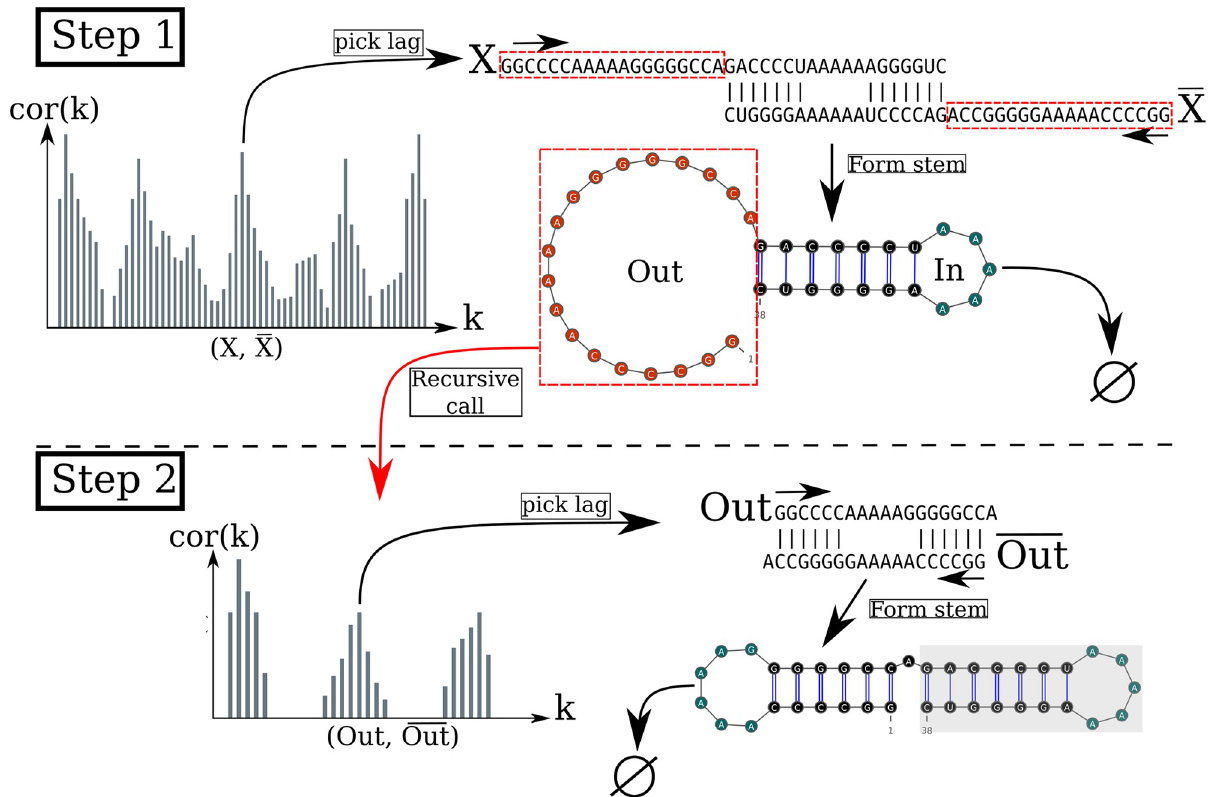
Fig 2. Algorithm execution for one example sequence which requires two steps. (Step 1) From the correlation cor ( k ), we select one peak which corresponds to a position lag k . Then, we search for the largest stem and form it. Two fragments, “In” (the interior part of the stem) and “Out” (the exterior part of the stem), are left, but only the “Out” may contain a new stem to add. (Step 2) The procedure is called recursively on the “Out” sequence fragment only. The correlation cor ( k ) between the “Out” fragment and its mirror is then computed and analyzing the k positional lags allows to form a new stem. Finally, no more stem can be formed on the fragment left (colored in blue), so the procedure stops.